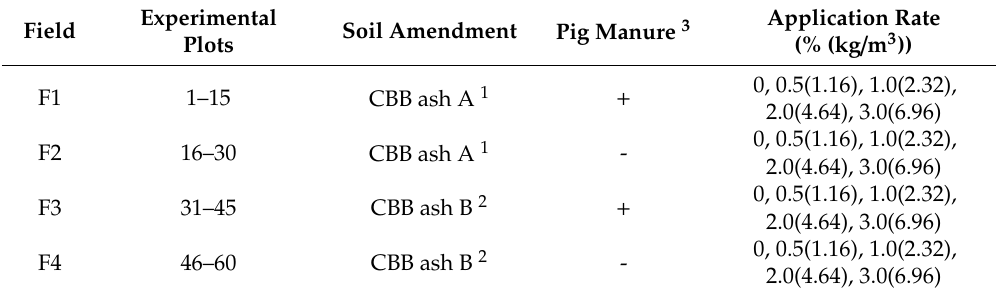
Table 3. Soil amendments and application rate in the experimental